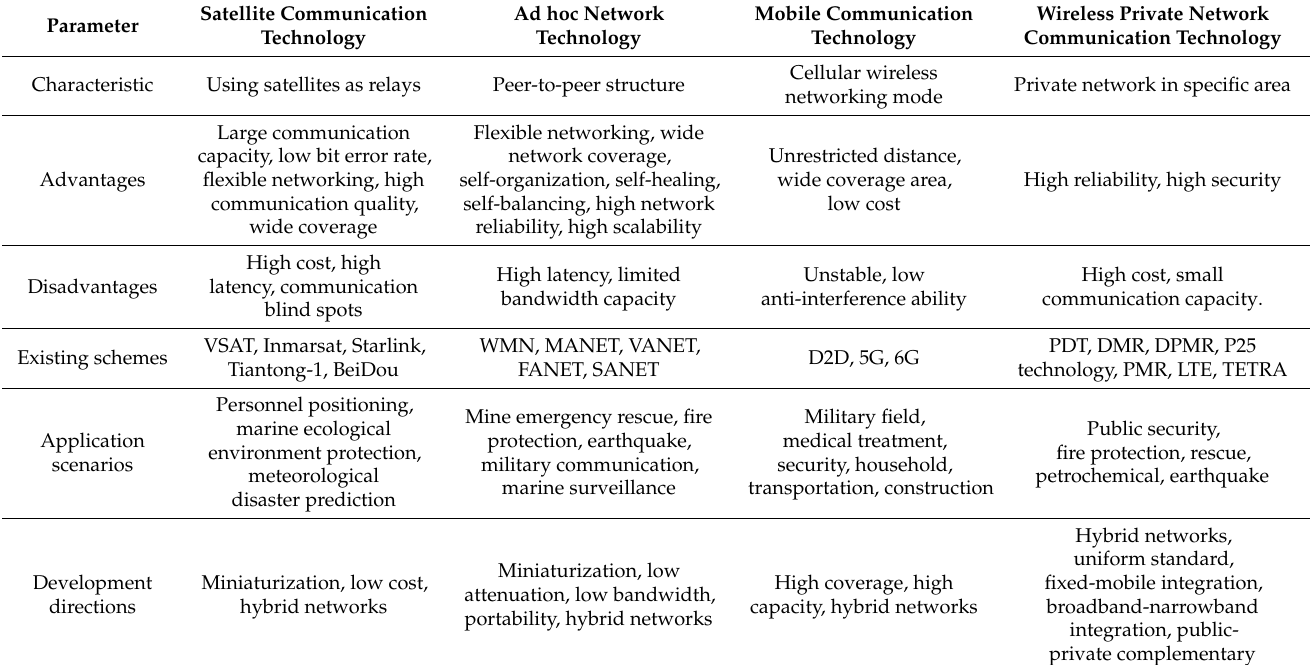
Table 7. The features of various emergency communication